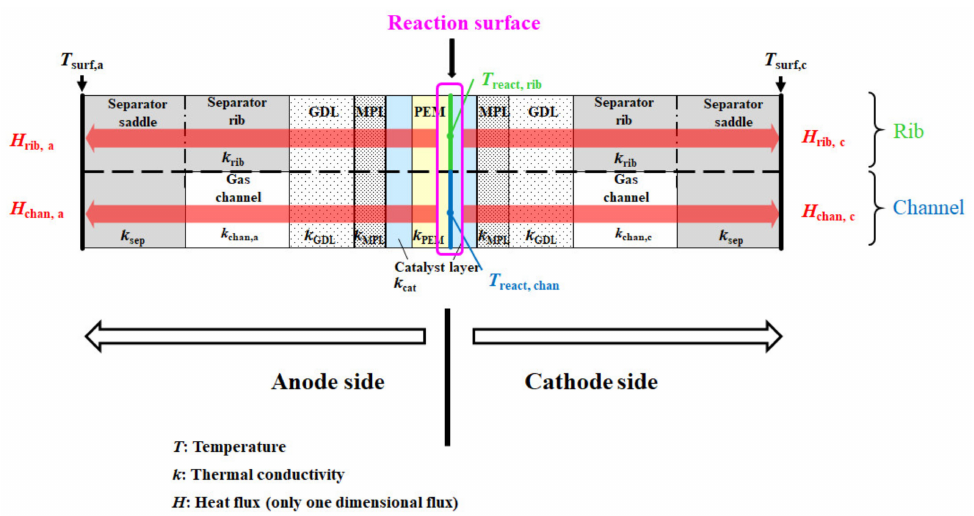
Figure 1. 1D multi-plate heat-transfer module proposed by this